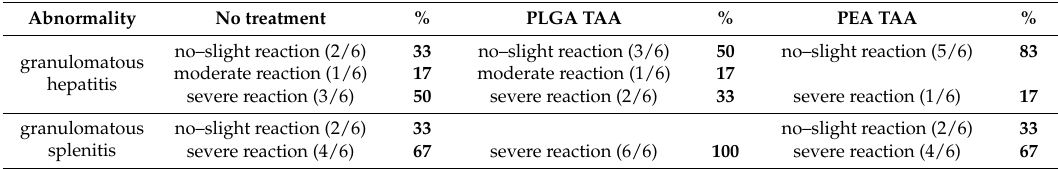
Table 1. Incidence of granulomatous hepatitis or granulomatous